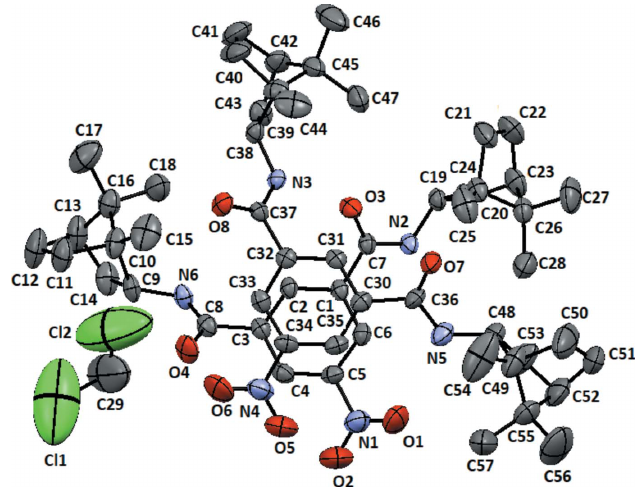
Figure 1 Asymmetric unit of title compound showing displacement ellipsoids drawn at the 40% probability level. Hydrogen atoms are omitted for